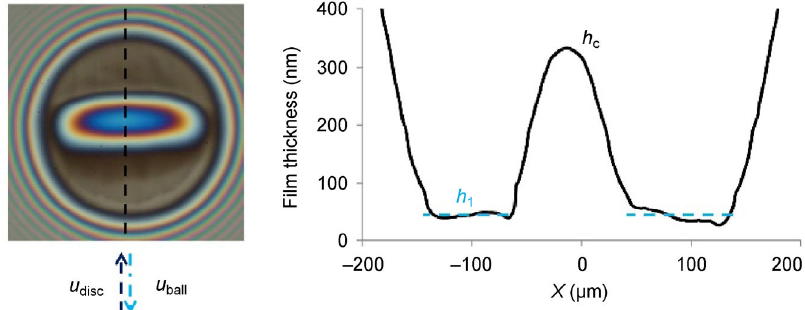
Fig. 4 Interferogram and centerline film thickness profile of an EHL contact under pure opposite sliding.